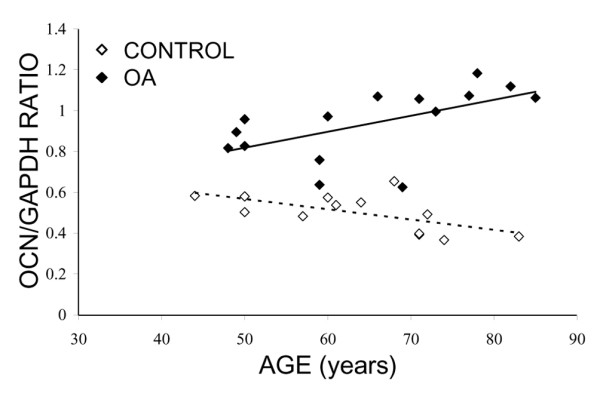
Changes in osteocalcin (OCN)/GAPDH mRNA with age. The relative OCN/GAPDH ratios were determined in intertrochanteric trabecular bone from individuals with osteoarthritis (OA) (n = 15) and control individuals (n = 13). In OA, OCN/GAPDH mRNA increased significantly with age (OCN/GAPDH = 0.01 [Age] + 0.43; r = 0.57, p < 0.03). In controls, OCN/GAPDH mRNA significantly declined with age (OCN/GAPDH = -0.01 [Age] + 0.82; r = -0.62, p < 0.03). GAPDH, glyceraldehyde-3-phosphate dehydrogenase.